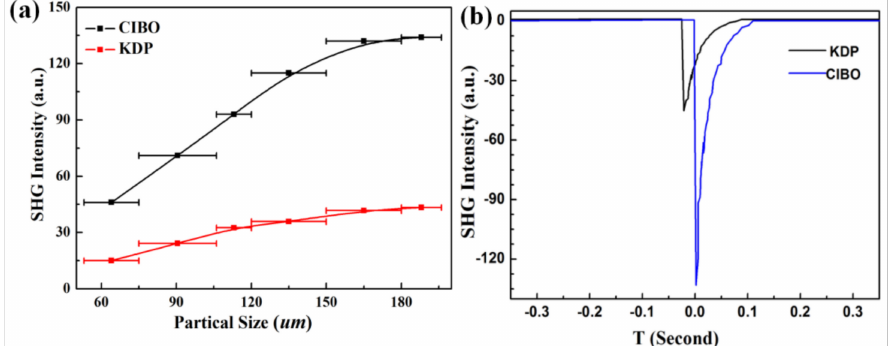
Figure 4. ( a ) Phase − matching curves for CIBO at 1064 nm and KDP (KH 2 PO 4 ) serving as a benchmark sample. ( b ) The SHG (second harmonic generation) signals at 150–180 µ m particle